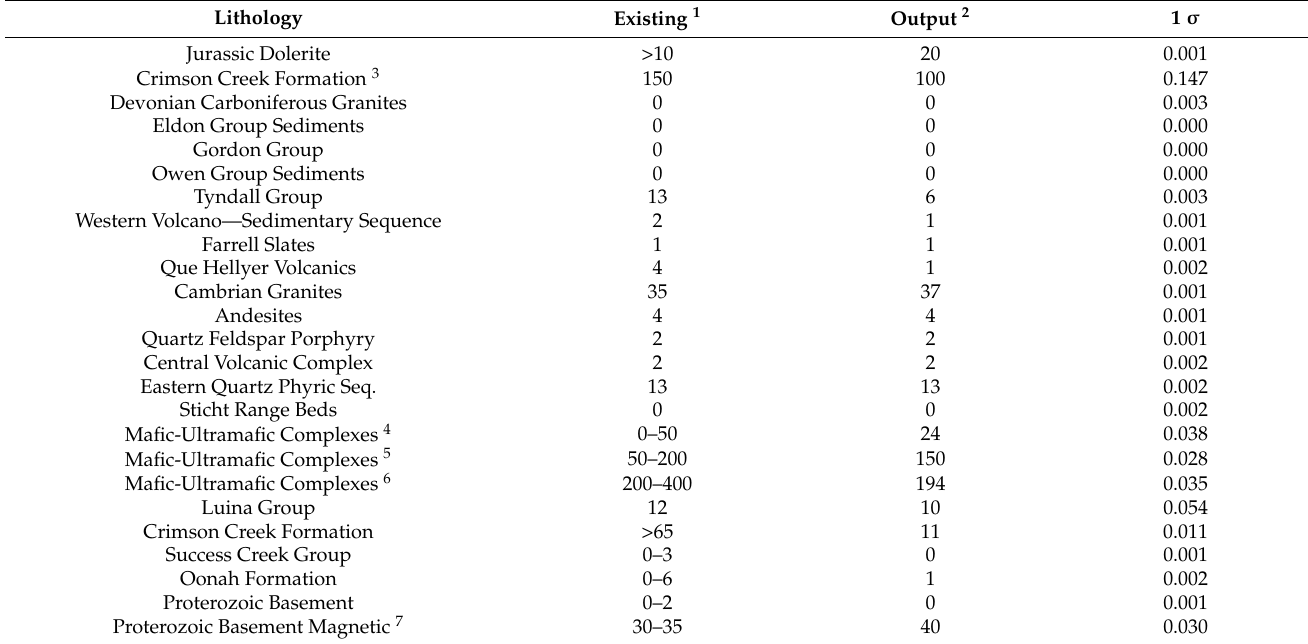
Table 2. Western Terrane existing and model-informed mean susceptibility (SI × 10 − 3